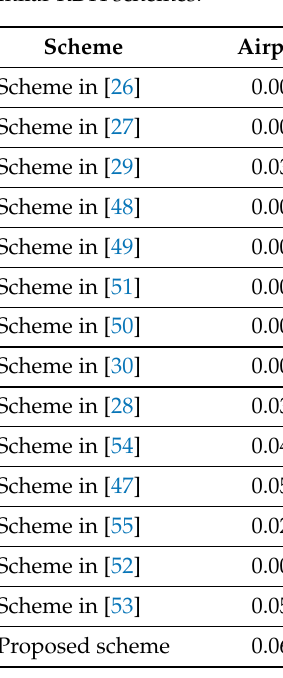
Table 5. Comparison of payload computed on airplane, baboon, boat and peppers images with similar RDH